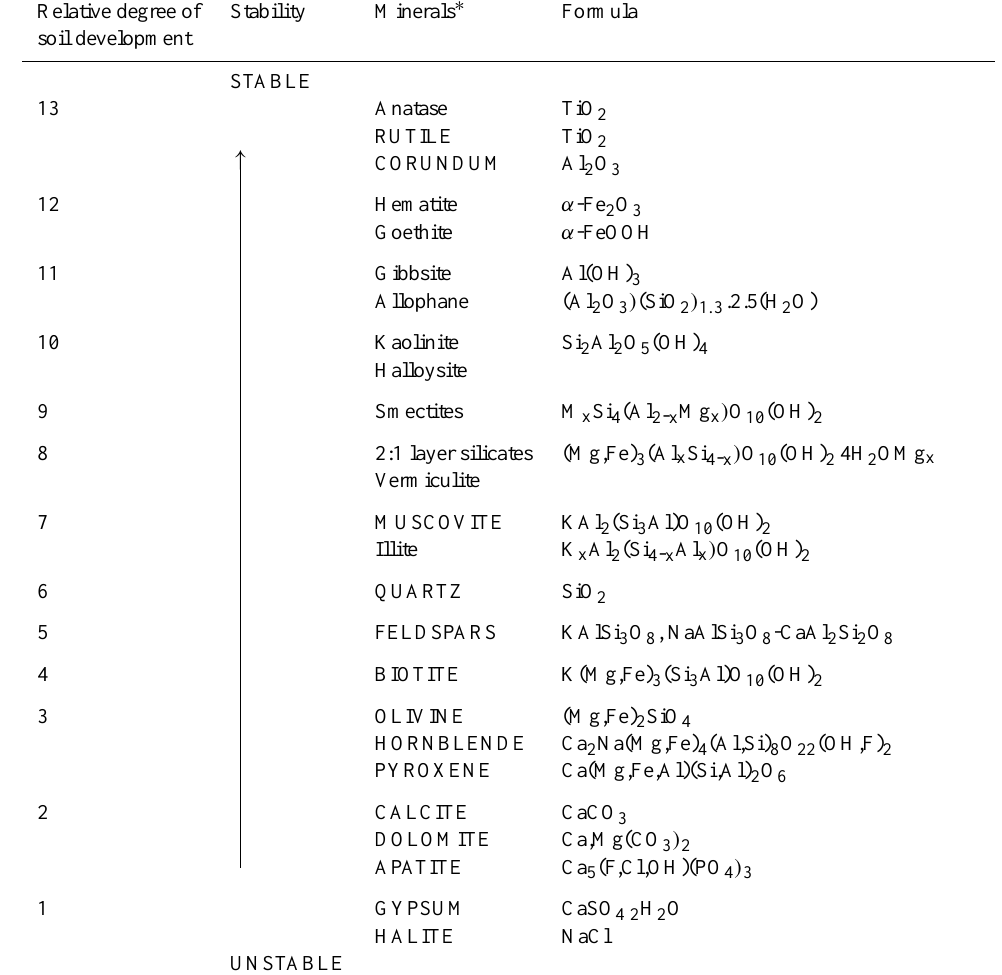
Table 1. Mineral weathering sequence (Goldich, 1938) and type of minerals as indicators of relative degree of soil development (the higher the number, the higher the degree of soil development) (Rai and Kittrick, 1989; Nagy, 1995; Allen and Hajek,